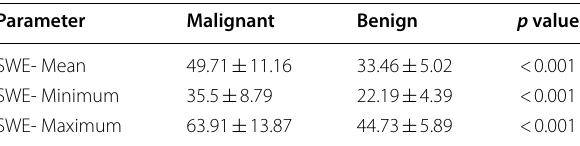
Table 4 Mean values of SWE waves according to histopathology findings among the studied group